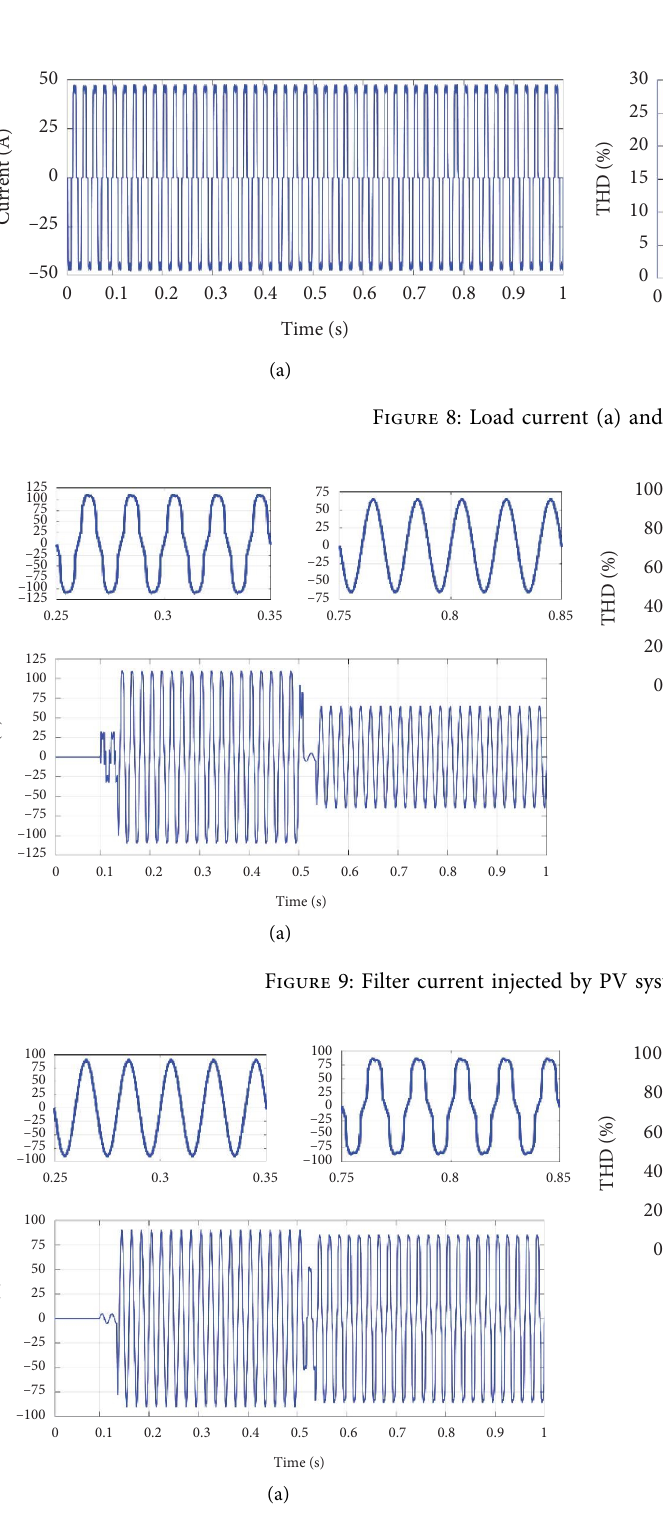
Figure 10: Filter current injected by wind generator (a) and its THD